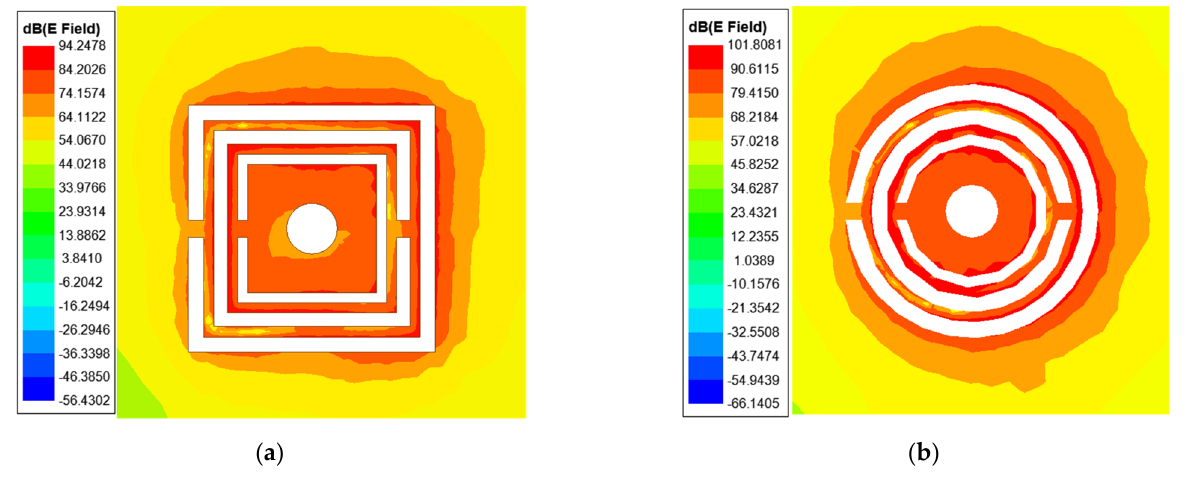
Figure 4. The simulated field distribution of ( a ) Rectangular rings; and ( b ) Circular rings.